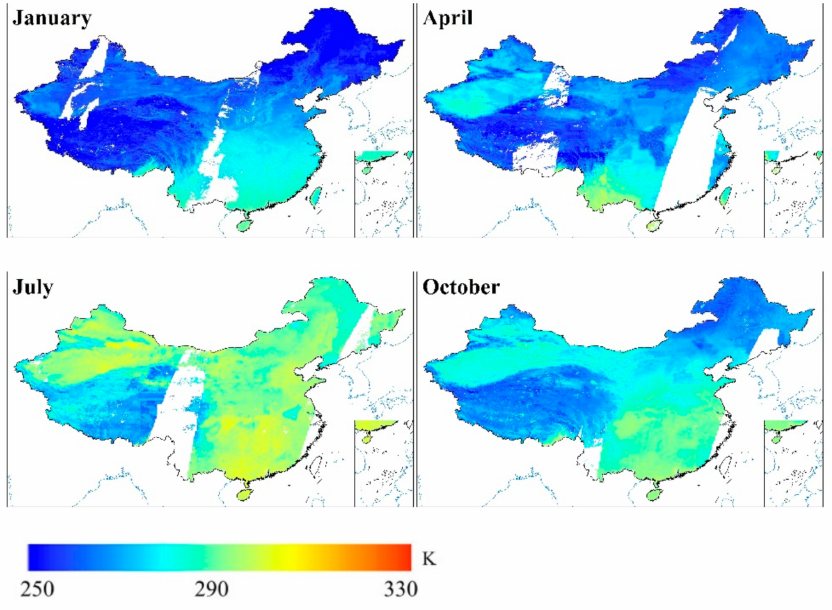
Figure 7. Spatial distribution of the fusion LSTs for nighttime of the 17th, 107th, 196th, and 291st days of the year 2010, representing different